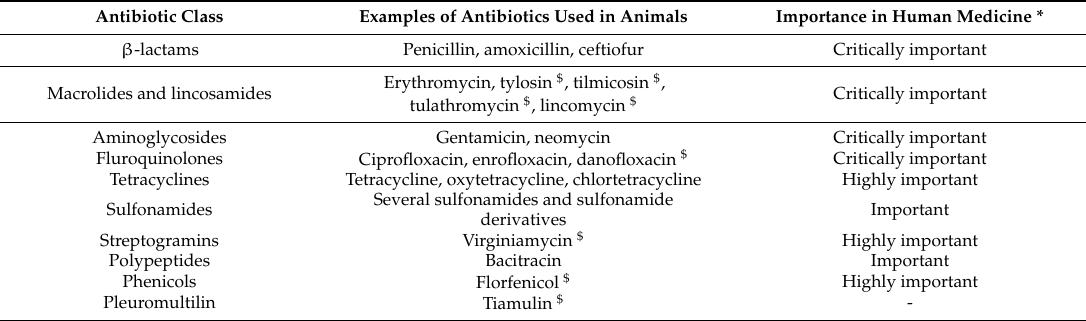
Figure 1. Global antimicrobial use in food animals ( a ) Major users of antimicrobials in livestock in 2010; ( b ) Major users of antimicrobials in livestock in 2030 (projected) [65]. Table 2. Antimicrobial classes important in human medicine used in animals [69].